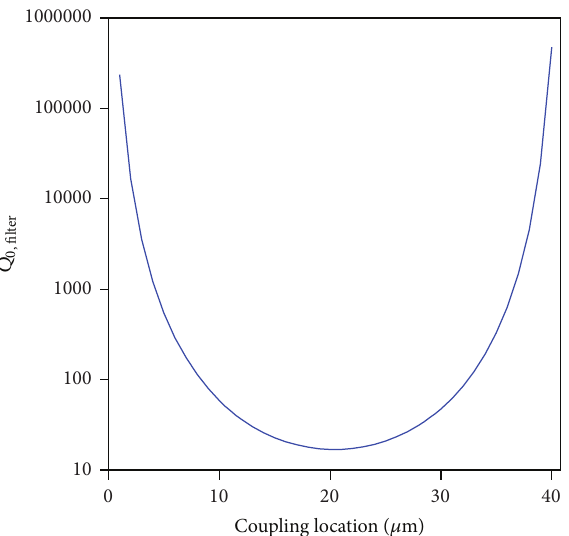
Figure15:Variationofthequalityfactoroftheunactuatedfilterwith the attachment location.